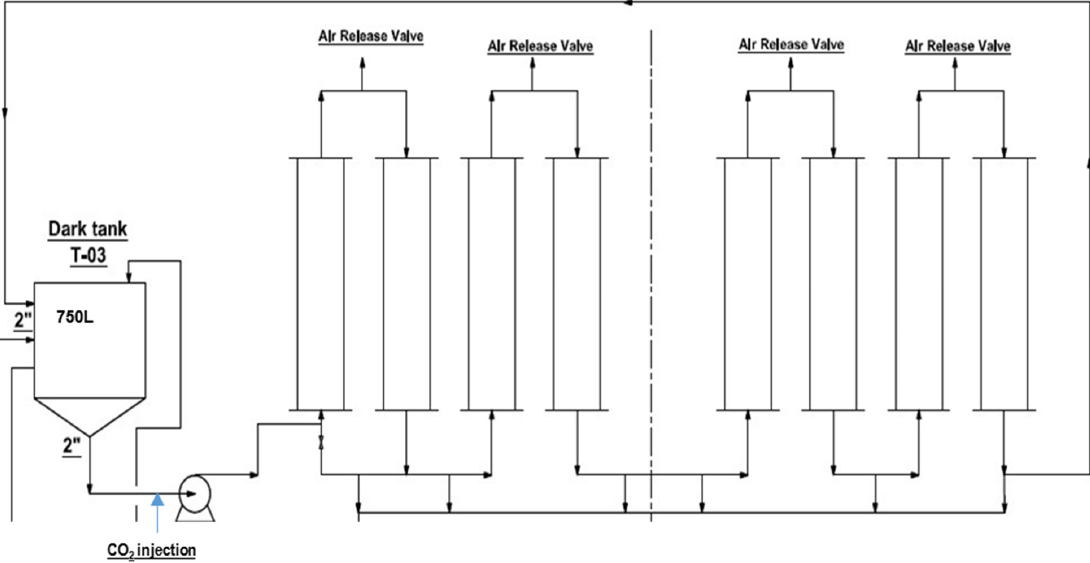
Figure 2. Vertical tubular photobioreactor (PBR, total capacity of 1500 L) used in this experimental study .